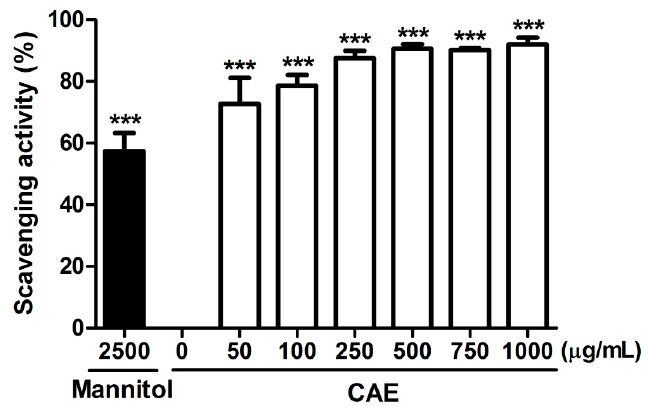
Figure 3. Hydroxyl radical scavenging activity (%) of CAE. Mannitol (2500 μ g/mL) was used as the positive control. CAE exhibited powerful hydroxyl radical scavenging activity. Significant difference versus control in each experiment: ***, p < 0.001.